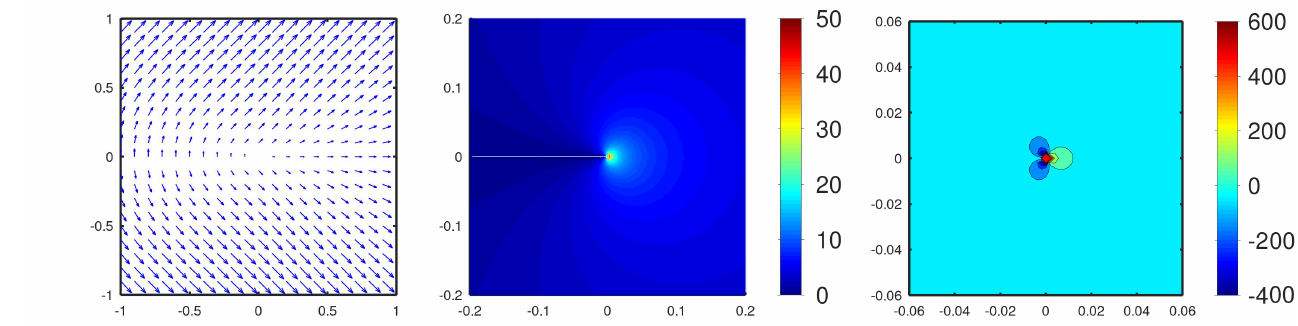
( div u ) ( right ) around the ∂ x 1